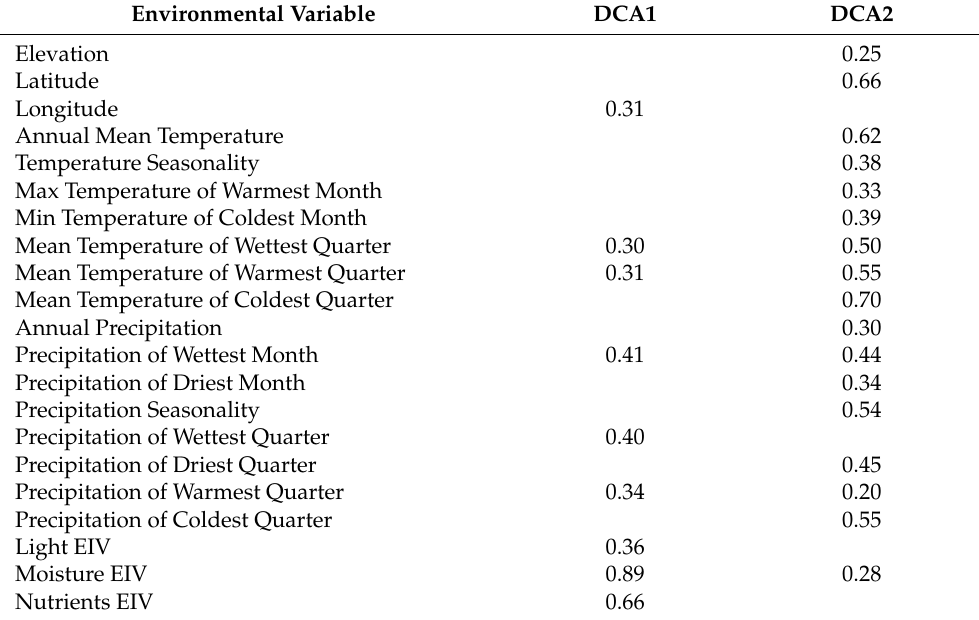
Table 1. Spearman correlations of the first two detrended correspondence analysis (DCA) axes, with environmental variables. Only significant correlations are presented ( p <